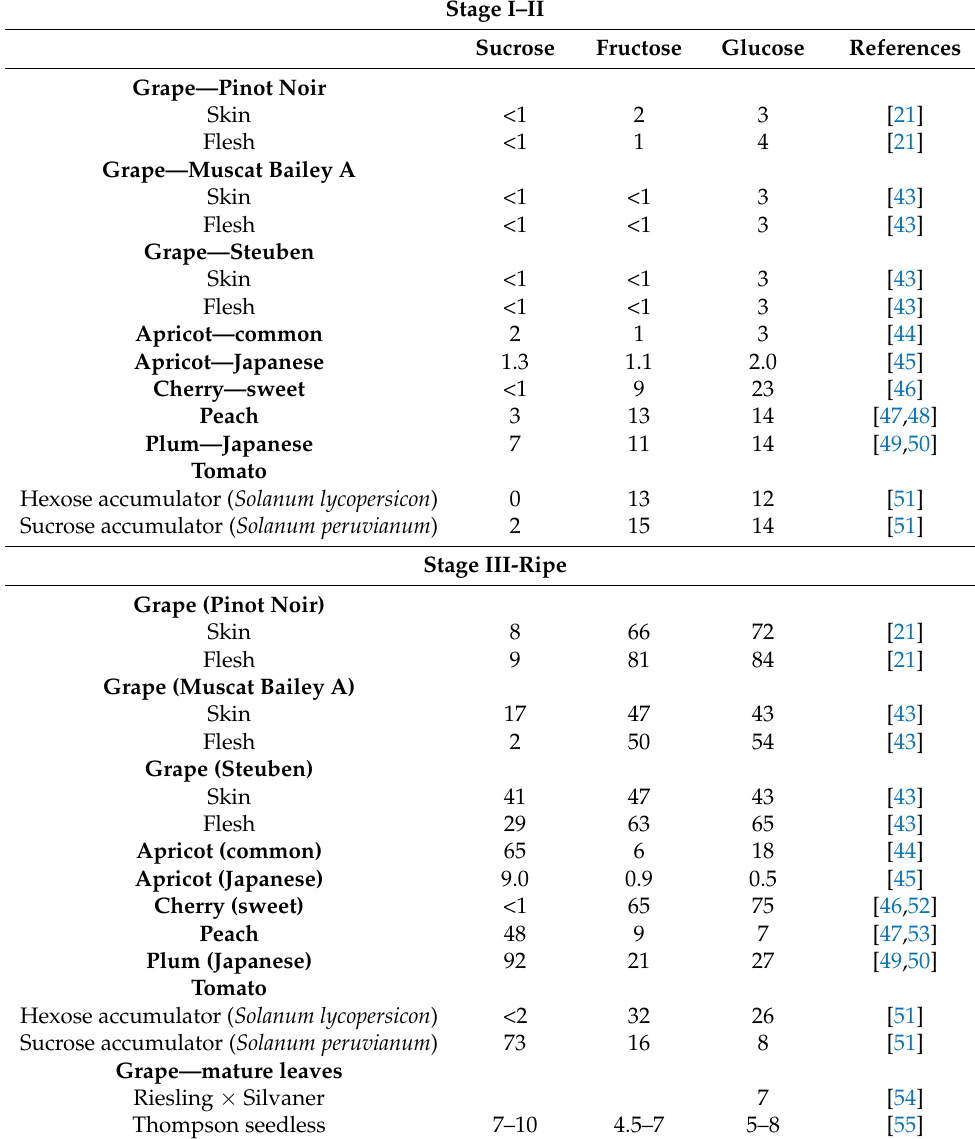
Table 1. Typical contents of soluble sugars (mg g − 1 FW) in the pericarp and leaves of grape and the flesh of some other fruits. Both Muscat Bailey A and Steuben are interspecific hybrids. Note apricot, cherry, peach and plum also accumulate sorbitol, and the contents of this compound for the cultivars given in this table are given in Walker et al. [1]. For grape berries, three stages of development termed I, II and III, can be distinguished. During stage I, the berry increases in size. During stage II, veraison occurs, and there is a slowing down of the growth rate. During stage III, ripening occurs and the berry increase in size. Ripening is accompanied by softening and compositional changes, such as a large decrease in organic acid and a substantial increase in the content of soluble sugars [9]. In this table, stage I–II correspond to the period up to veraison and stage III to the last part of the ripening